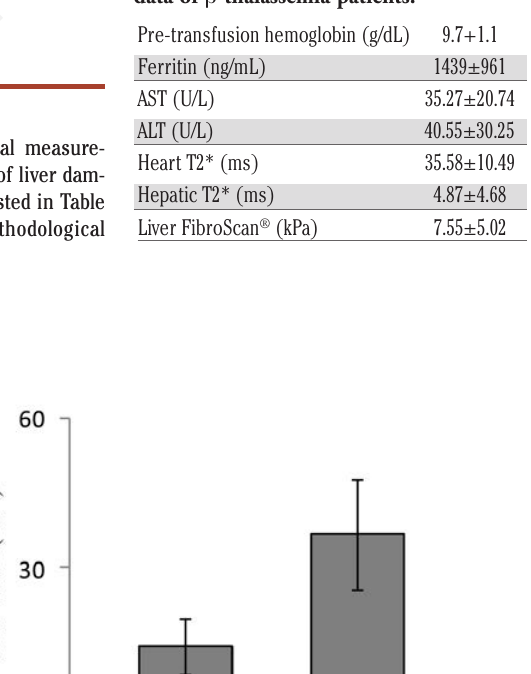
t-test).Table 1. Hematological and instrumental data of b -thalassemia